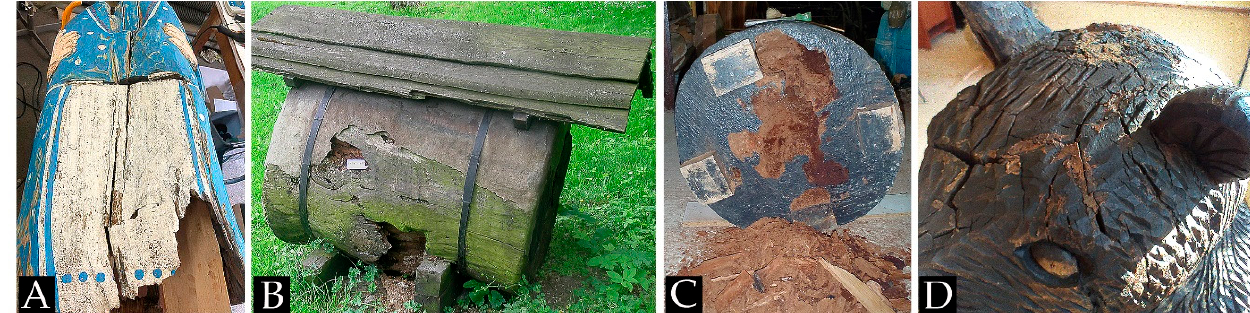
Figure 5. Structural damage of wooden objects that threatens their existence (artefacts from the collections of The Museum of Apiculture in Swarz ę dz ( B , C ), and The National Museum of Agriculture and Food Industry in Szreniawa, Poland ( A , D )).